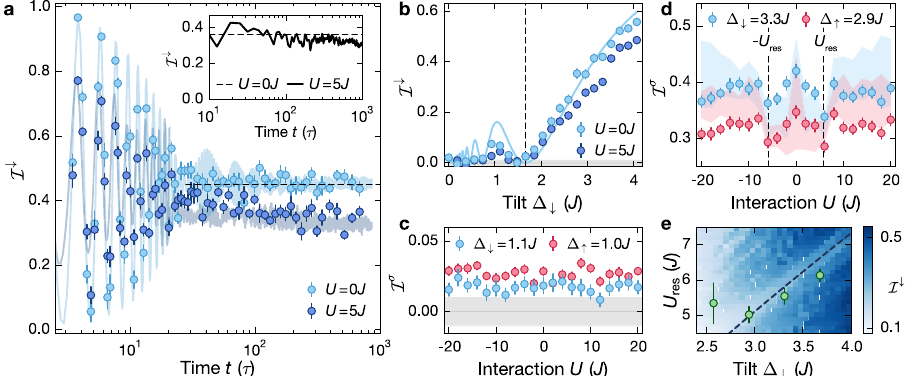
Fig. 3 Long-time dynamics. a Imbalance time traces at Δ ↓ = 3.30(3) J and J / h = 0.54(1)kHz for U = 0 J (spin-polarized, light blue) and U = 5 J (spin- resolved measurement, dark blue). The shaded trace is an ED calculation for L = 16 ( “ Methods ” ). Each data point is averaged over 12 individual experimental realizations. Inset: ED calculation for L = 16 in a clean system with Δ ↓ = Δ ↑ = 3 J , ω h = 0 and U = 5 J using a Néel-ordered initial CDW. The dashed lines show the analytic prediction for the non-interacting steady-state imbalance [Eq. (3)]. b Steady-state imbalance versus Δ ↓ measured at U = 0 J (spin-polarized, light blue) and U = 5 J (spin-resolved measurement, dark blue). Each data point is averaged over ten equally spaced times in a time window between 70 τ and 100 τ ( U = 0 J ) and 340 τ and 370 τ ( U = 5 J ). The solid line shows the analytic prediction for I # [Eq. (3)] and the dashed line indicates the fi rst root of the Bessel function at Δ ≈ 1.5 J . c Spin-resolved steady-state imbalance versus interaction strength at Δ = 1.10(1) J . Each point is averaged over ↓ ↓ ten time steps equally spaced between 170 τ and 200 τ . d Spin-resolved steady-state imbalance versus interaction strength as in ( c ) for Δ ↓ = 3.30(3) J . The shaded trace is an ED simulation, which is averaged over the same time steps as in ( c ) and where the width indicates the 1 σ standard deviation. e Resonances extracted from interaction scans for U > 0 as in ( d ) for different tilt values (Supplementary Note 12). The color plot shows ED calculations for the same parameters as in the experiment, but with ω h = 0, for L = 13 sites. The dashed line indicates the analytic prediction for the resonance U Δ J 2 = ð 3 Δ res ’ 2 # (cid:2) 8 # Þ . The gray shaded area in (b),(c) indicates our calibrated detection resolution. In all panels error bars denote the